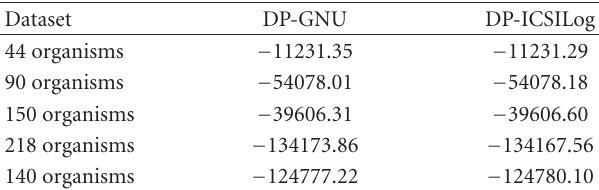
Table 1: Log-likelihood score deviation with DP-ICSILog.